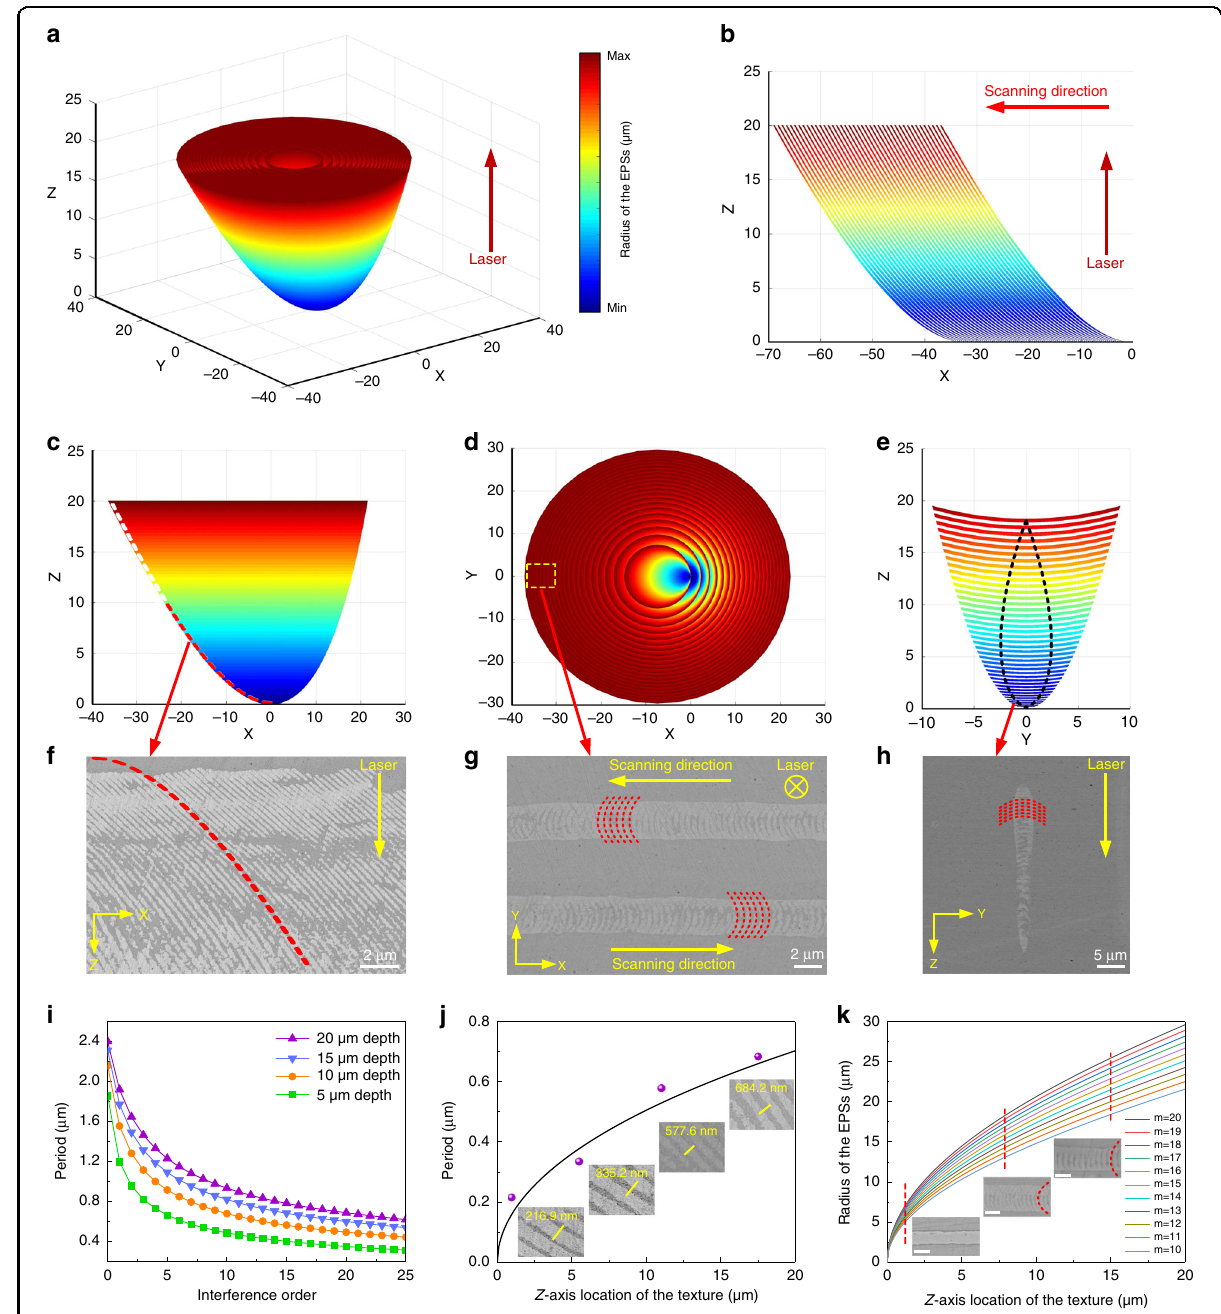
Fig. 2 3D interference and mechanism of texture generation. a The calculated EPSs of the 3D interference fi eld. b The simulated texture constructed by the SOPTL in the XZ plane. c The XZ view of the EPSs. The dotted curve is the calculated edge of an equal-phase face. d , e The XY view ( d ) and YZ view ( e ) of the EPSs. The dotted area shows the EPSs work in the SOPTL. f SEM image of the generated photonic textures in the XZ plane. The dotted curve is the calculated edge of the equal-phase face. g , h SEM images of the photonic textures in the XY plane ( g ) and YZ plane ( h ). The dotted curves help to visualize the curved stripes in the actual photonic textures corresponding to the simulated results. i Periods of the photonic textures at different depths as a function of the interference order. j Calculated period of the photonic textures as a function of depth with the interference order set as 20. Insets are the observed periods, corresponding to the purple points in the image. k Radii of the EPSs with different interference orders as a function of depth. Insets are the XY view of the photonic textures at different depths (indicated by the dotted lines). The dotted curves in the insets help to visualize the bending degree. Scale bar: 2